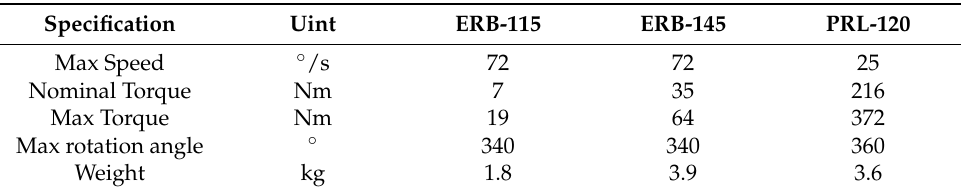
Table 5. Specifications of the